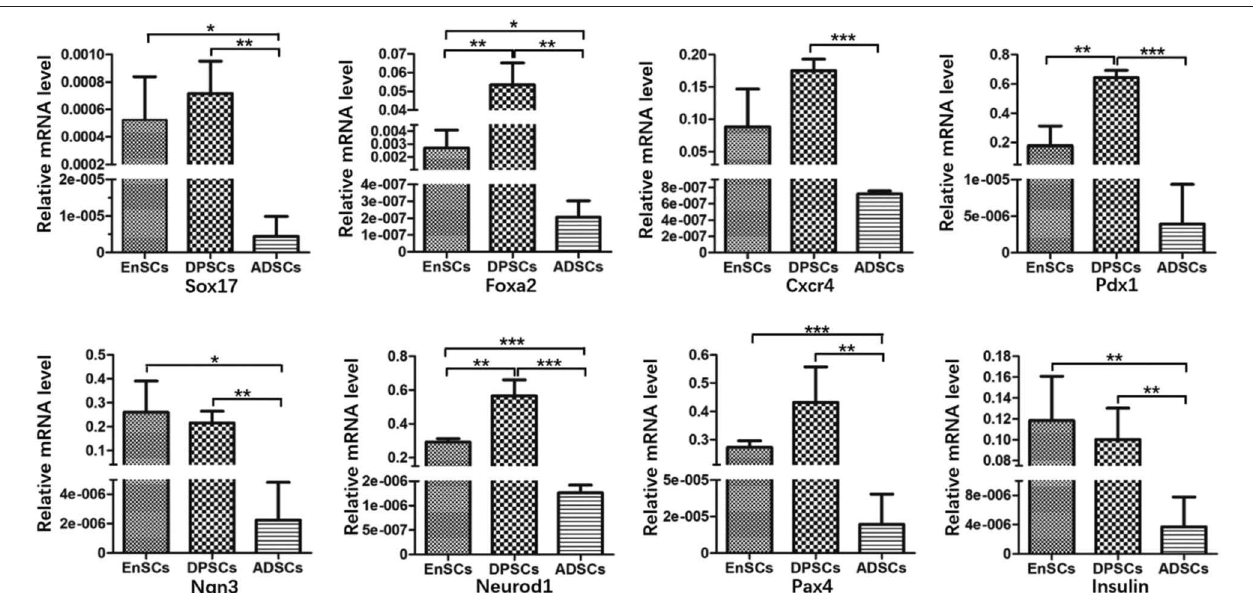
FIGURE 4 | Gene expression analysis of hEnSCs, hDPSCs and hADSCs. The expression levels relative to the housekeeping gene (GAPDH) are shown. The data are presented as the means ± standard deviation (SD) of 3 experiments; * p < 0.05, ** p < 0.01, *** p <